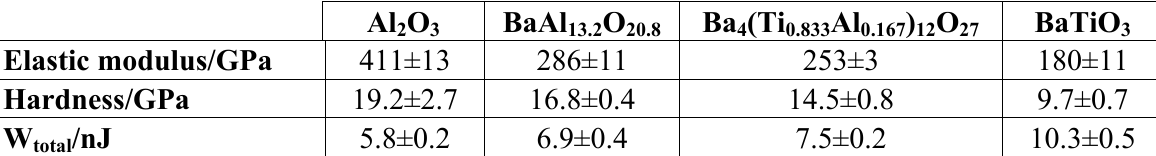
-platelet composite as determined by using the nano-indentation 3